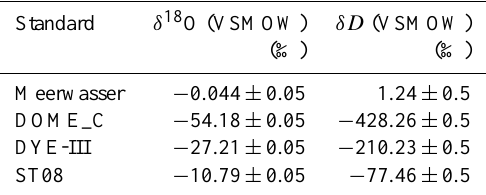
Table 1. Isotopic composition of internal standard waters used for calibration determined independently by